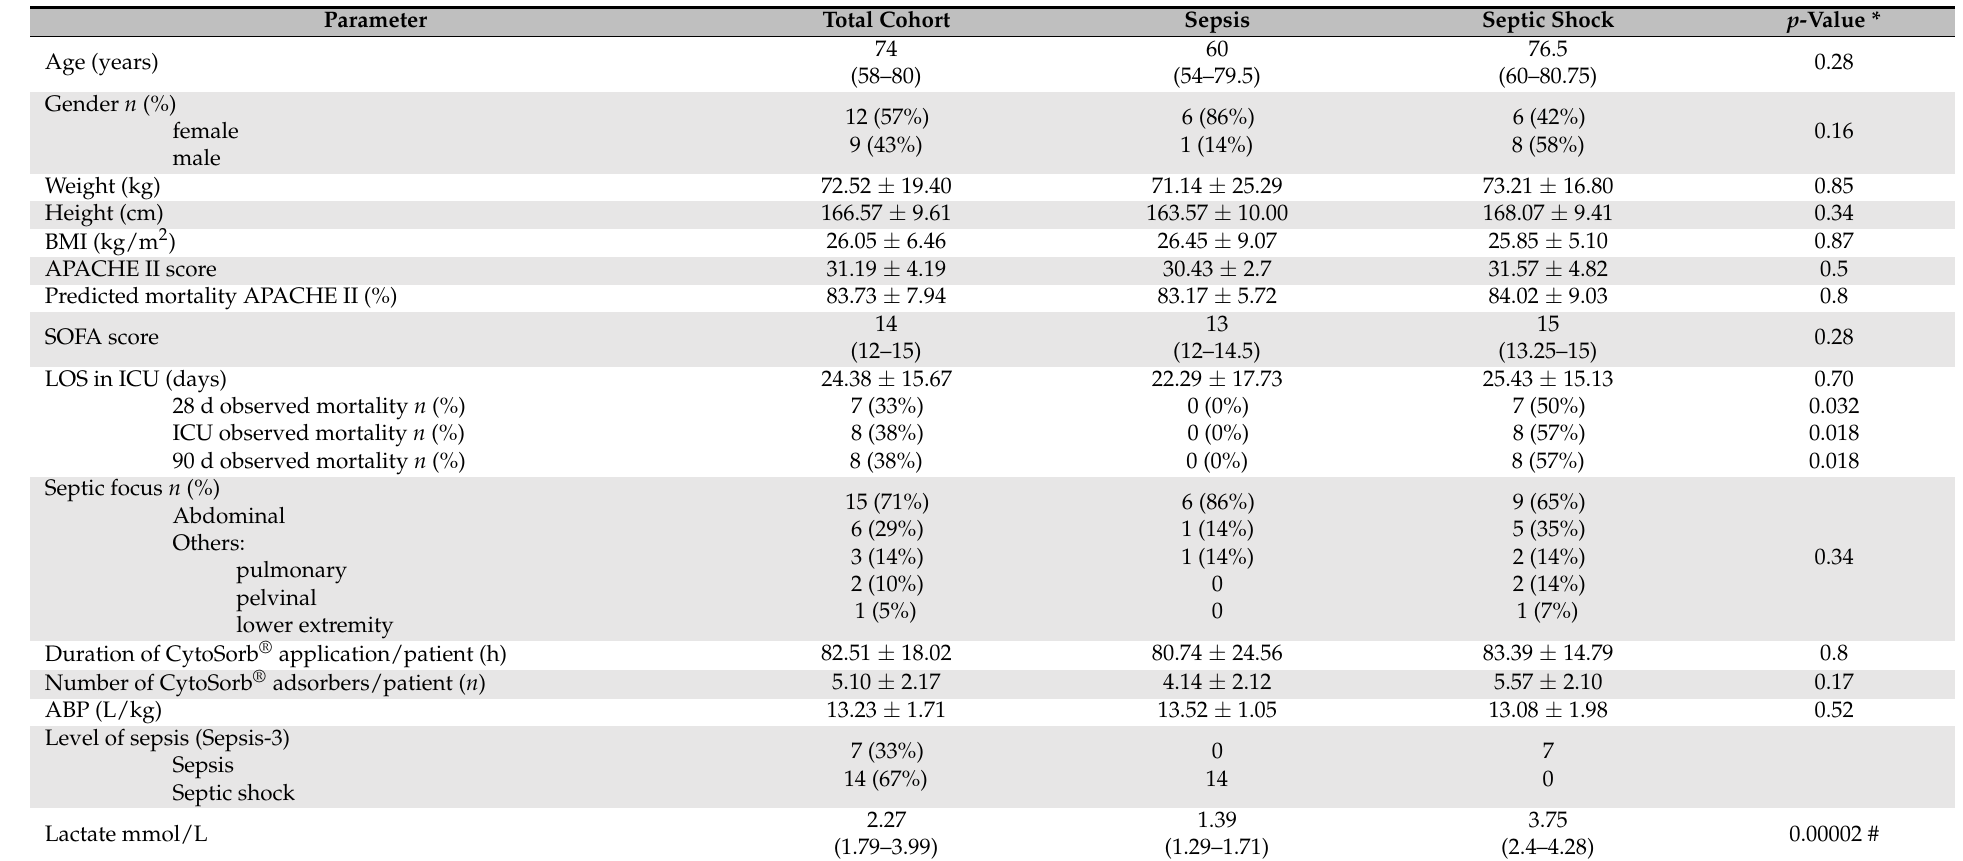
Table 1. Baseline of demographic and clinical